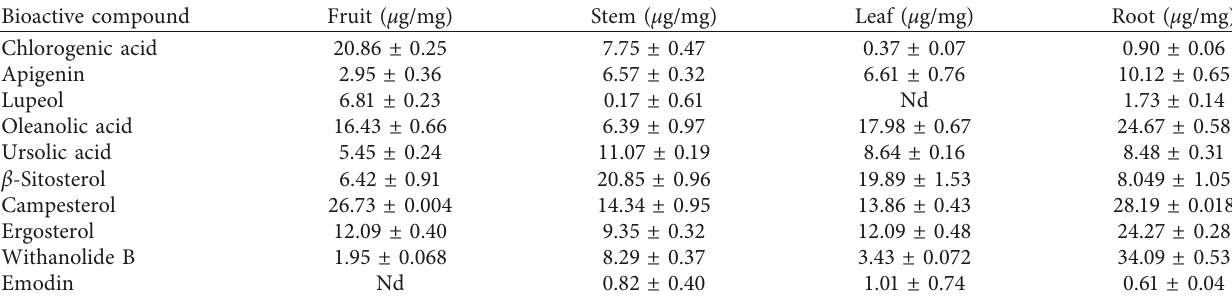
Table 3: Phytochemical studies in different plant parts of selected marker compounds in S. xanthocarpum by using HPTLC. Bioactive